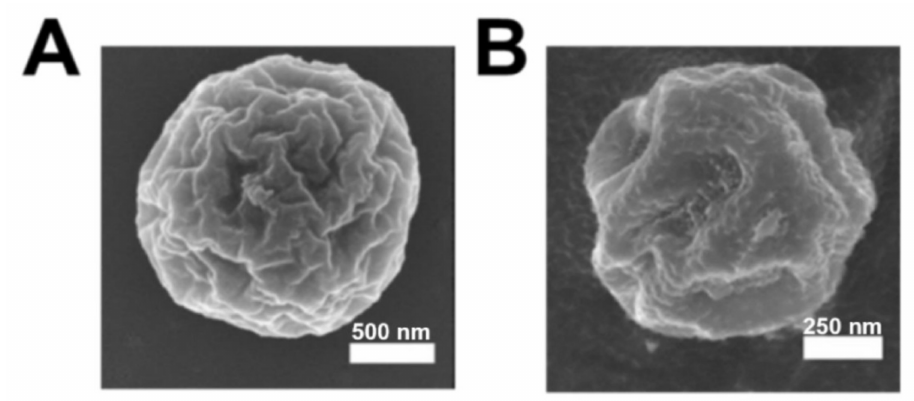
Figure 3. ( A ) SEM and ( B ) cryo-SEM of HByp4 (250 µ M, 10 mM HEPES, pH 7.0) treated with Fe(II) (250 µ M). Scale bars: 500 and 200 nm,